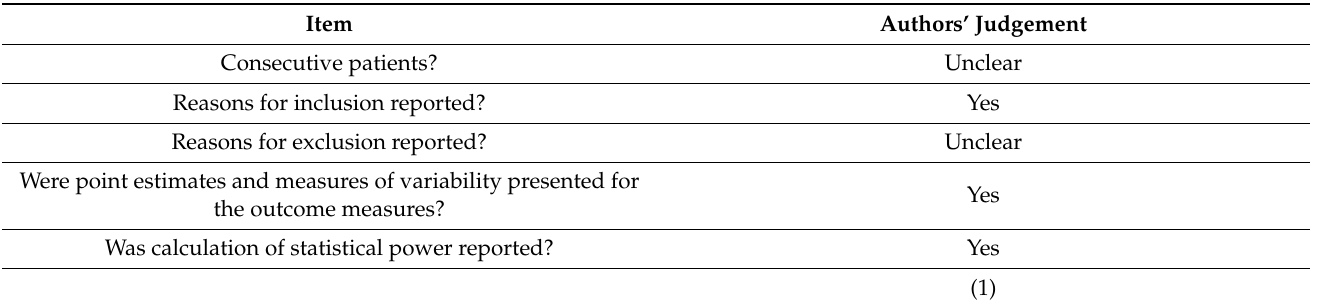
Table A17. Quality assessment.